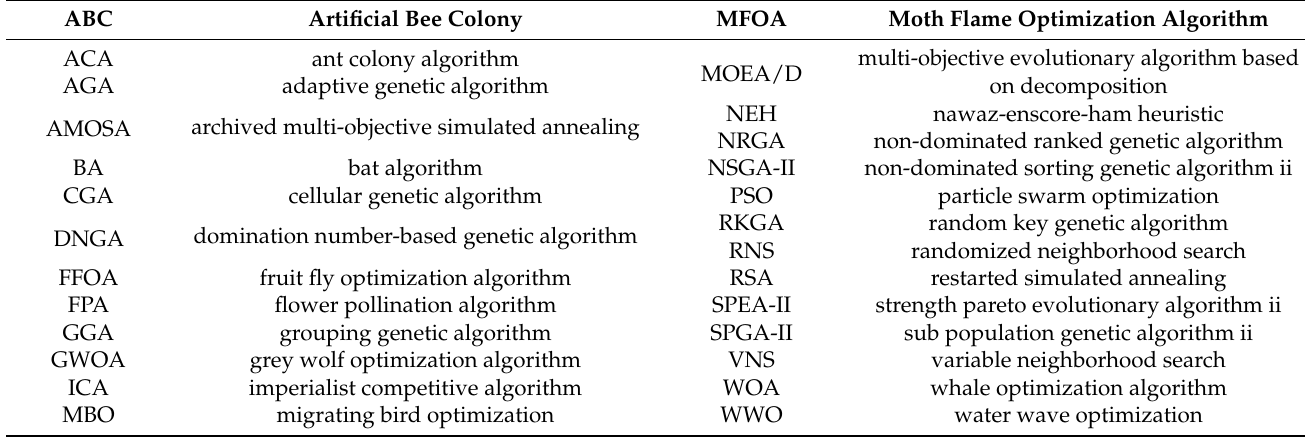
Table 1. Algorithm